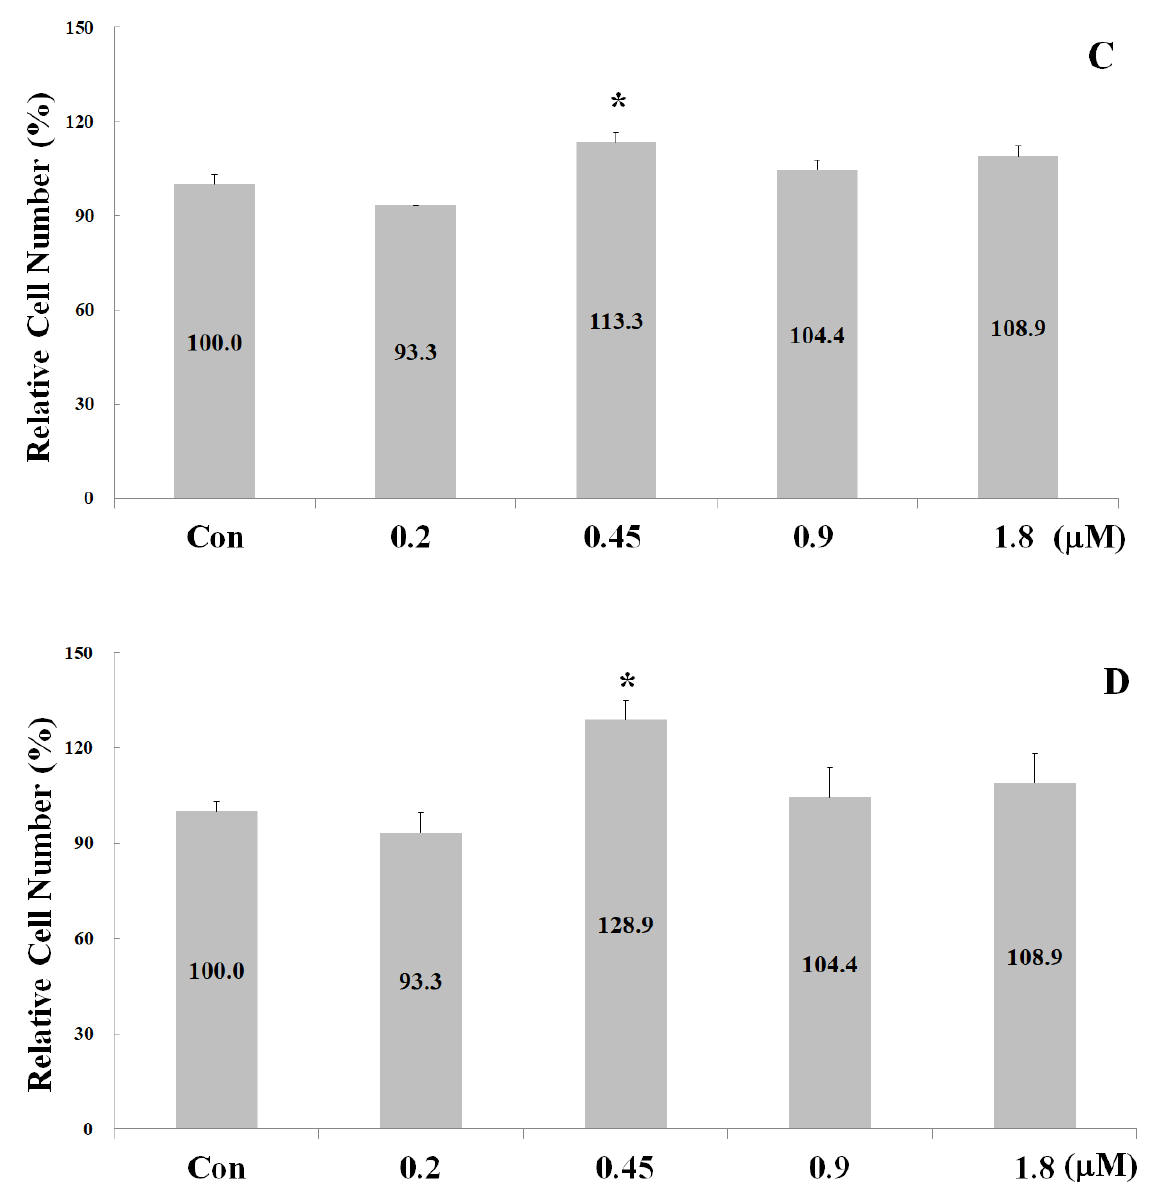
Figure 2. Effects of the synthetic peptides on osteoblast proliferation after treatment for 24 h. ( A ) Peptide 5, ( B ) Peptide 4, ( C ) Peptide 3, and ( D ) Peptide 2. Note: Data are presented as means ± SD in three independent experiments. The differences between the various peptide concentration treat‑ ments and the control groups ( A – D ) were analyzed using a one‑tailed test, * p <